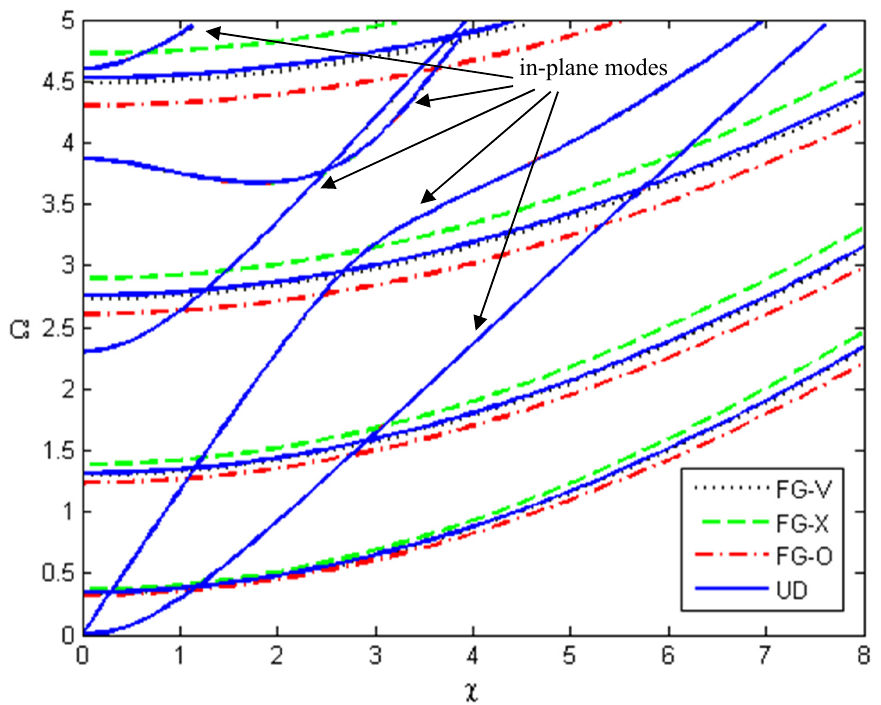
Figure 5. The dispersion spectra of FG-GPLs reinforced plates with different GPLs distribution patterns.